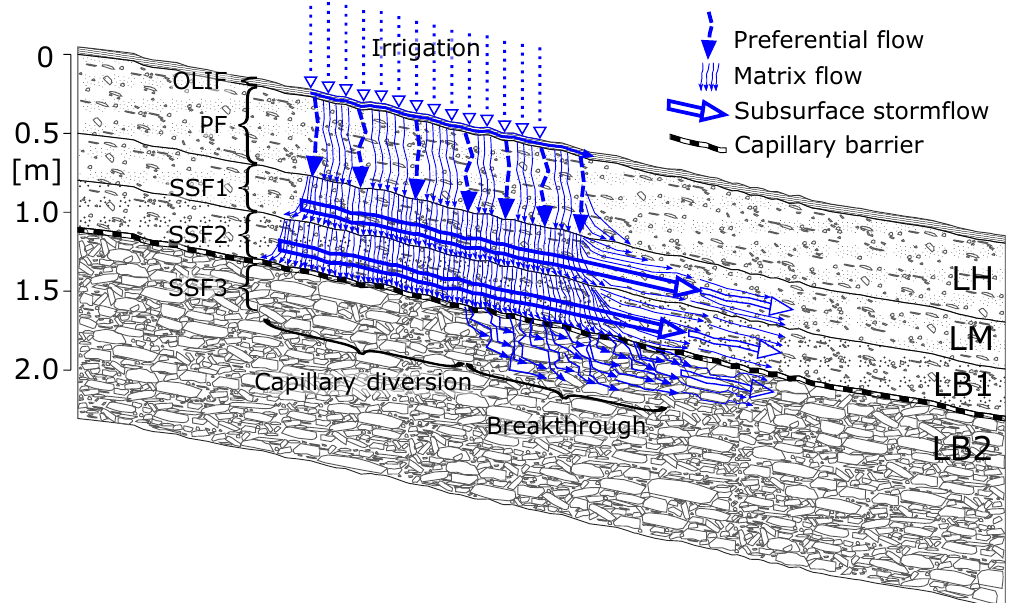
Figure 10. Conceptual model of water movement within the individual layers during the irrigation experiments (OLIF – organic layer interflow; PF – preferential flow; SSF – subsurface stormflow)